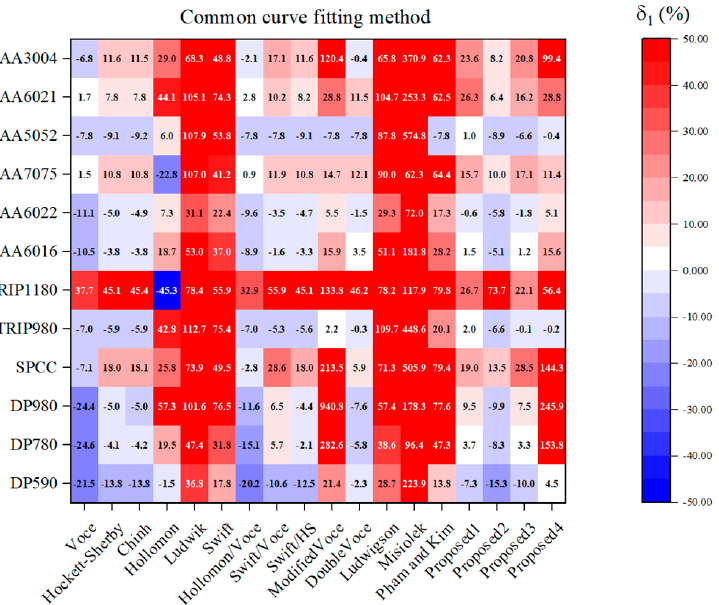
Figure 6. Percentage errors of diffuse neck prediction of all examined hardening laws identified by the common curve fitting method.